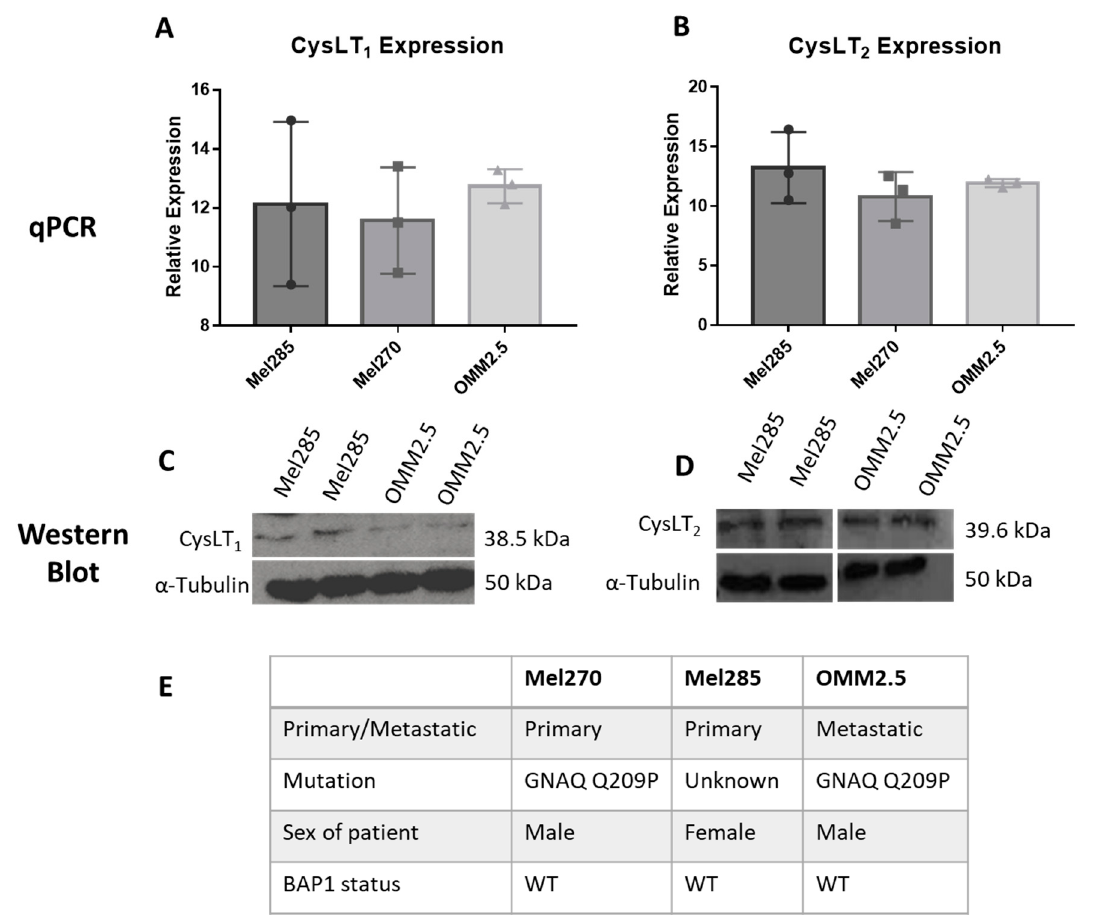
Figure 4. CysLT 1 and CysLT 2 are expressed in uveal melanoma cell lines. qPCR analysis confirmed the expression of CysLT 1 ( A ) and CysLT 2 ( B ) mRNA in UM cell lines, Mel285, Mel270, and OMM2.5 ( n = 3). Western blot analysis confirmed the expression of CysLT 1 ( C ) and CysLT 2 ( D ) in Mel285 and OMM2.5 cells ( n = 2). ( E ) Characteristics of UM cell lines used in this study. Statistical analysis was carried out using a paired t -test. Data are expressed as mean + SEM.